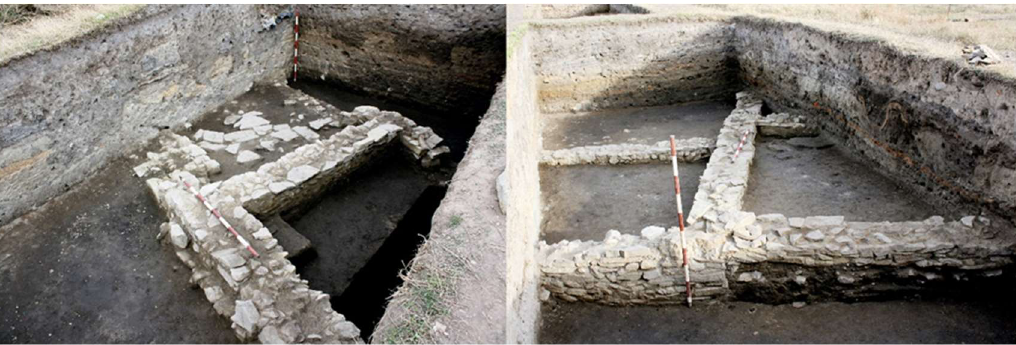
Figure 4. Halmyris, Romania, 2014, extramuros area. Residence 1.